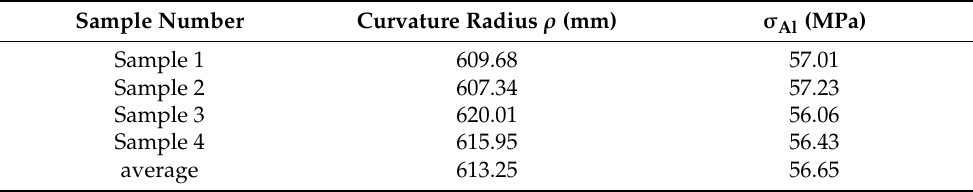
Table 4. The residual stress values obtained by the layer removal method.